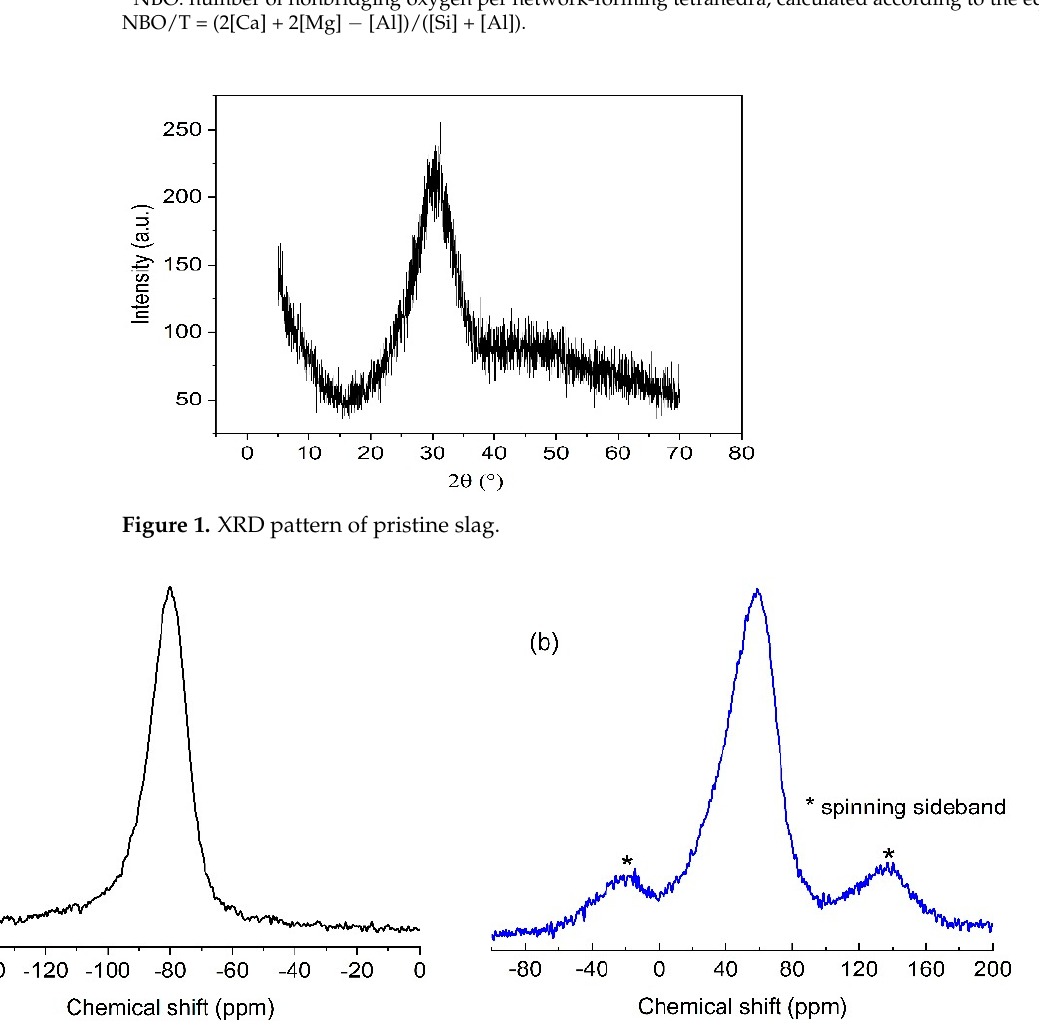
Figure 2. Solid state 29 Si ( a ) and 27 Al ( b ) MAS NMR spectra of pristine